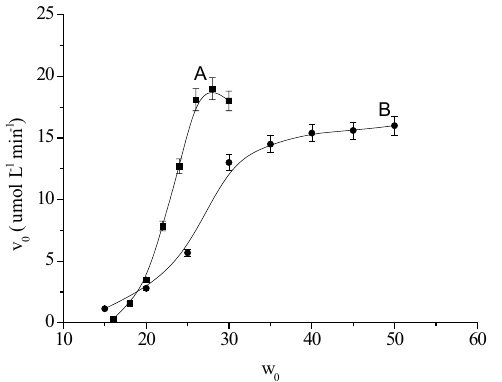
Figure 1. Effect of ω on the catalytic activity of YADH in the GGDE/ 0 TX-100 mixed reverse micelle (pH = 10.1, A) and AOT reverse micelle (pH = 8.0, B).